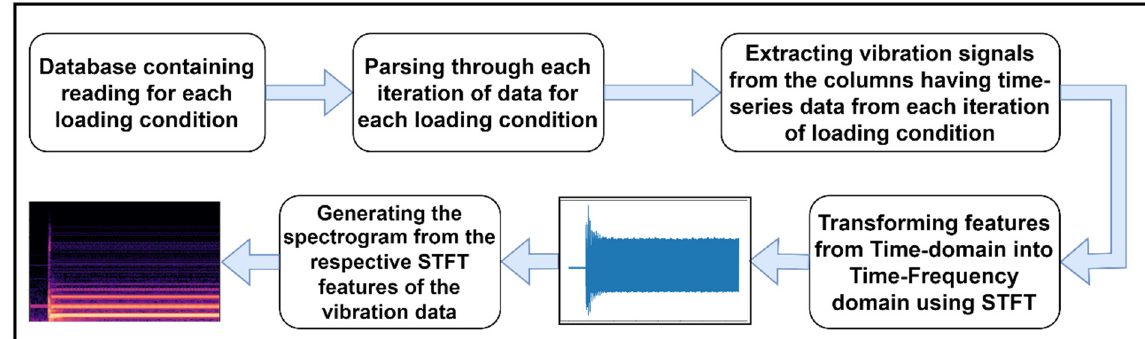
Figure 5. Steps involved in spectrogram generation from raw data.